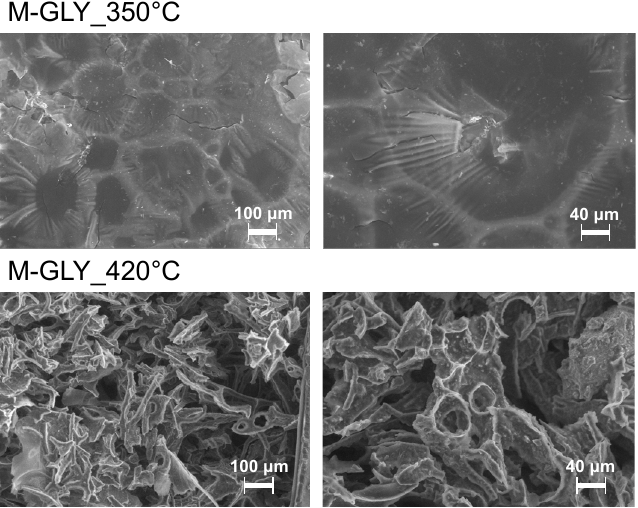
Figure 5. SEM micrographs at 250× and 500× of M ‐ GLY residues at 350 °C and 420 °C.